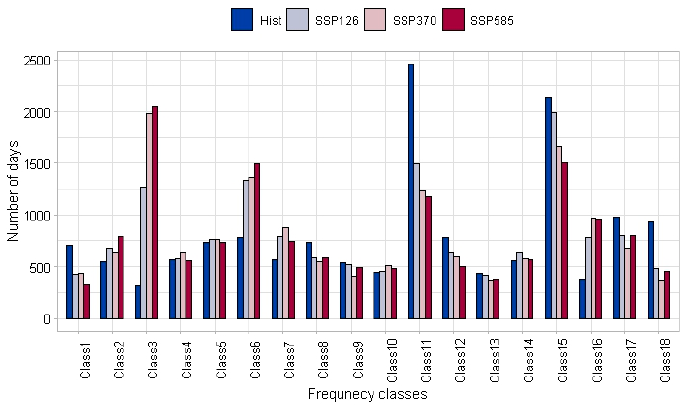
Figure 2. The frequency of the 18 clusters in the historical period and SSP126, SSP370, and SSP585 in ESM1_2_HR model.